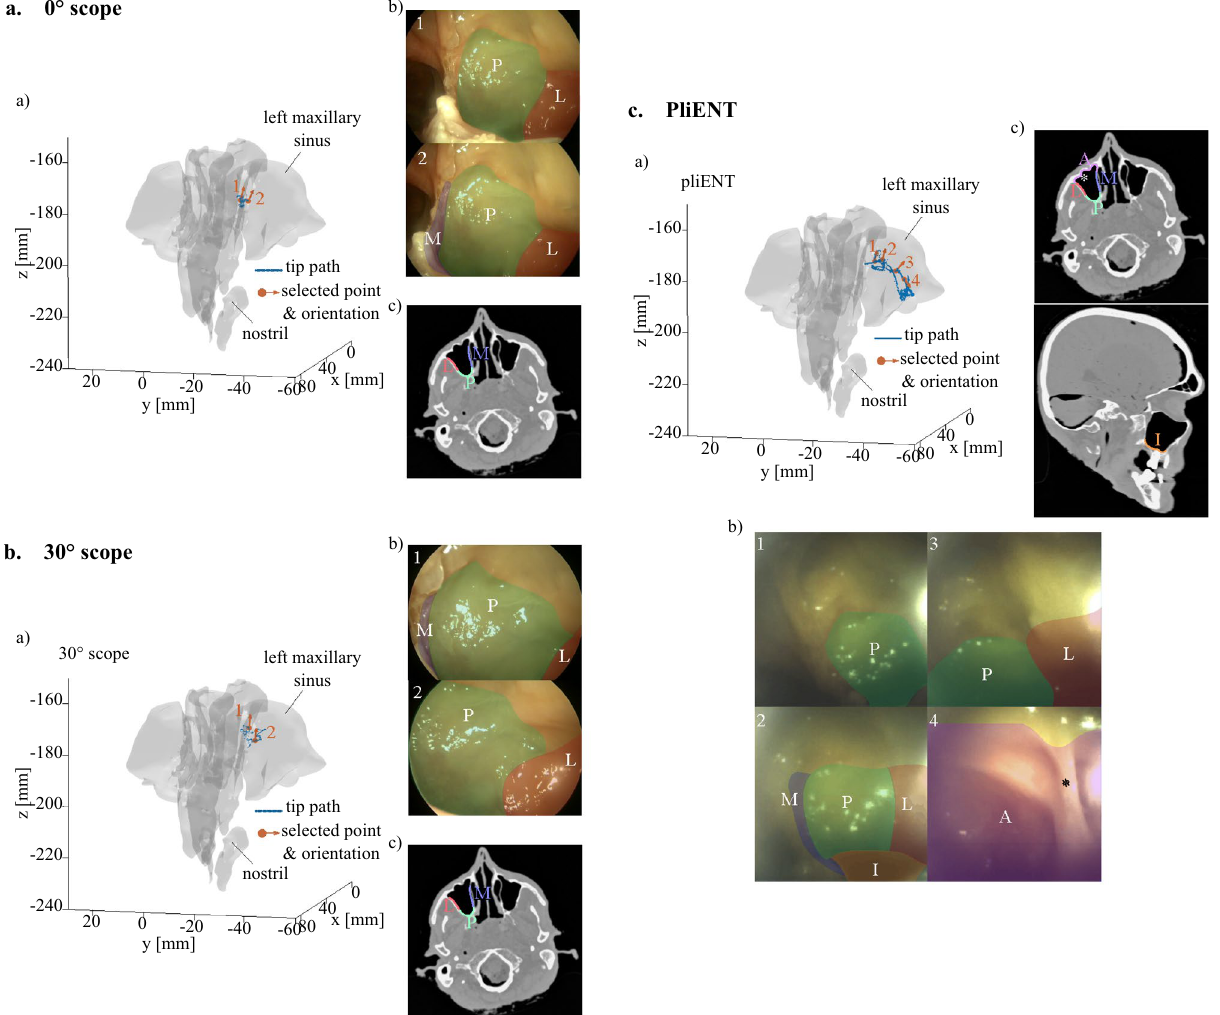
Figure 7. Field of view from points (points 1, 2,3 and 4) taken from the path made by the ( a ) 0° scope, ( b ) 30° scope, and ( c ) PliENT scope during inspection of the left maxillary sinus through an antrostomy. (a) 3D path (blue points) and selected points (orange points). The orientation of the instrument at the selected points is indicated by an arrow; (b) Endoscopic view at the selected points with highlight of the different maxillary sinus walls; (c) CT scan in the transverse plane of the cadaver head with highlight of the different walls visible on the endoscopic views. P = posterior wall; L = lateral wall; M = medial wall; A = anterior wall; I = inferior wall or floor; (*) partial